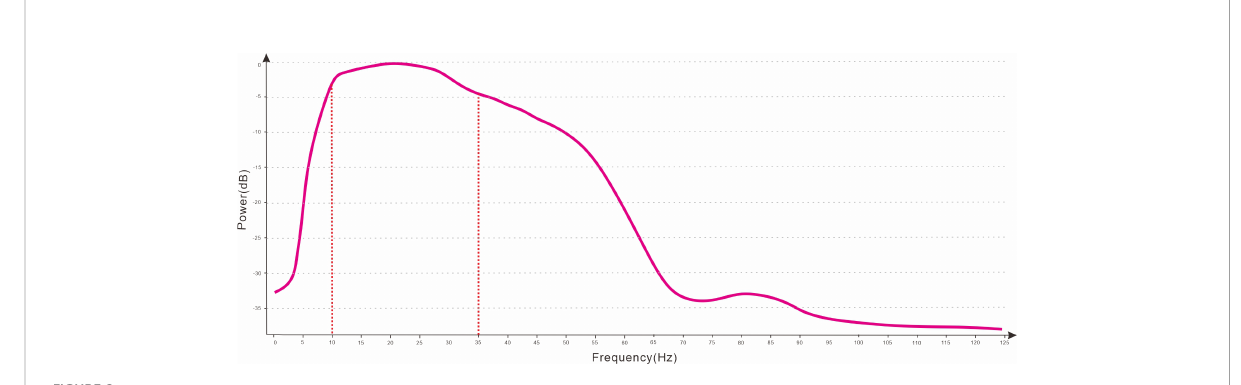
FIGURE 2 Spectral analysis of the seismic data volume in the Taoerhe Sag. The main frequency range is 10~35 Hz. The high frequency range is 70~85